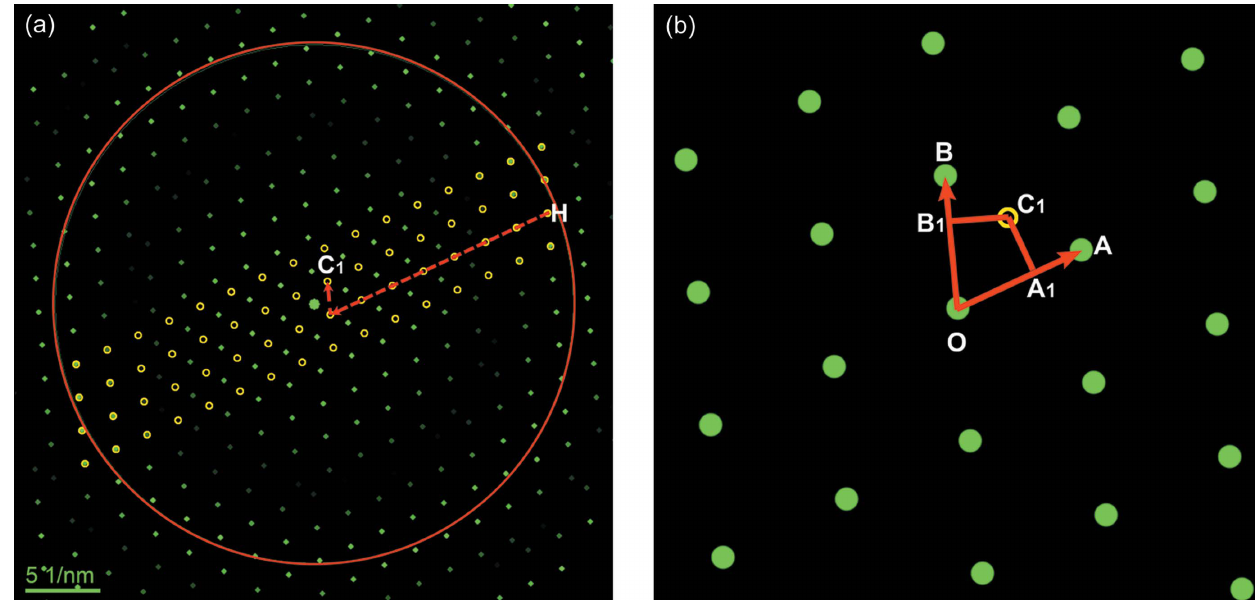
Figure 2 Illustrative construction of a 3D reciprocal cell using a simulated diffraction pattern with HOLZ reflections. ( a ) Simulated [211] zone-axis diffraction pattern with ZOLZ and HOLZ reflections for the monoclinic crystal La 2 (Ti 2 O 7 ) (listed in Table 1). The red circle marks the HOLZ ring and the open yellow dots are generated by repeating the FOLZ reflections and then superimposed onto the ZOLZ layer. A typical FOLZ reflection, H, is shifted by integral multiples of the basic vectors of OA and OB to the position C 1 . ( b ) Enlarged ZOLZ pattern shows 2D geometrical relationship between the basic vectors OA and OB , and the spot C 1 (shifted from H), together with the perpendicular intersection points A 1 and B 1